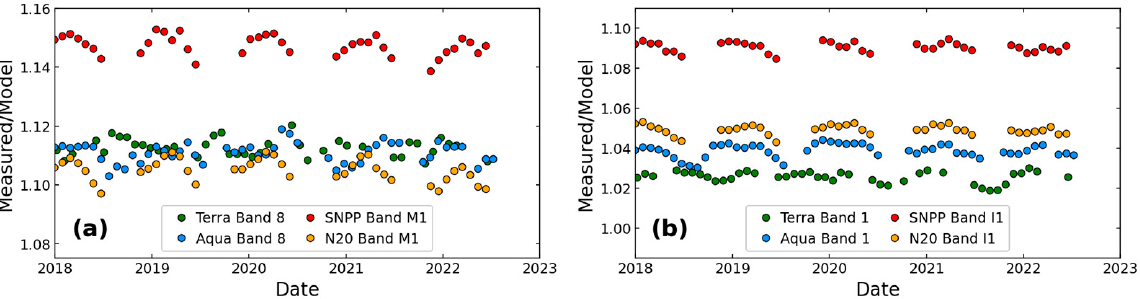
Figure 8. Trending measured/model data for bands in all four instruments near ( a ) 0.412 μ m (MODIS band 8, VIIRS Band M1) and ( b ) 0.640 μ m (MODIS Band 1, VIIRS Band I1).